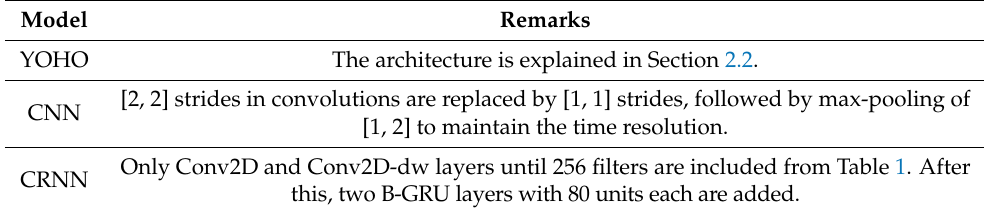
Table 3. Models for comparison on the in-house test set for music-speech detection.